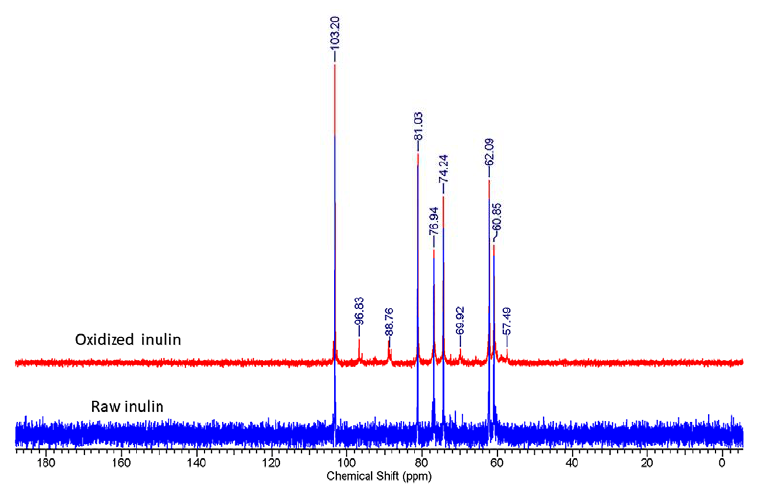
Figure 13. 13 C NMR spectra of inulin and oxidized inulin.